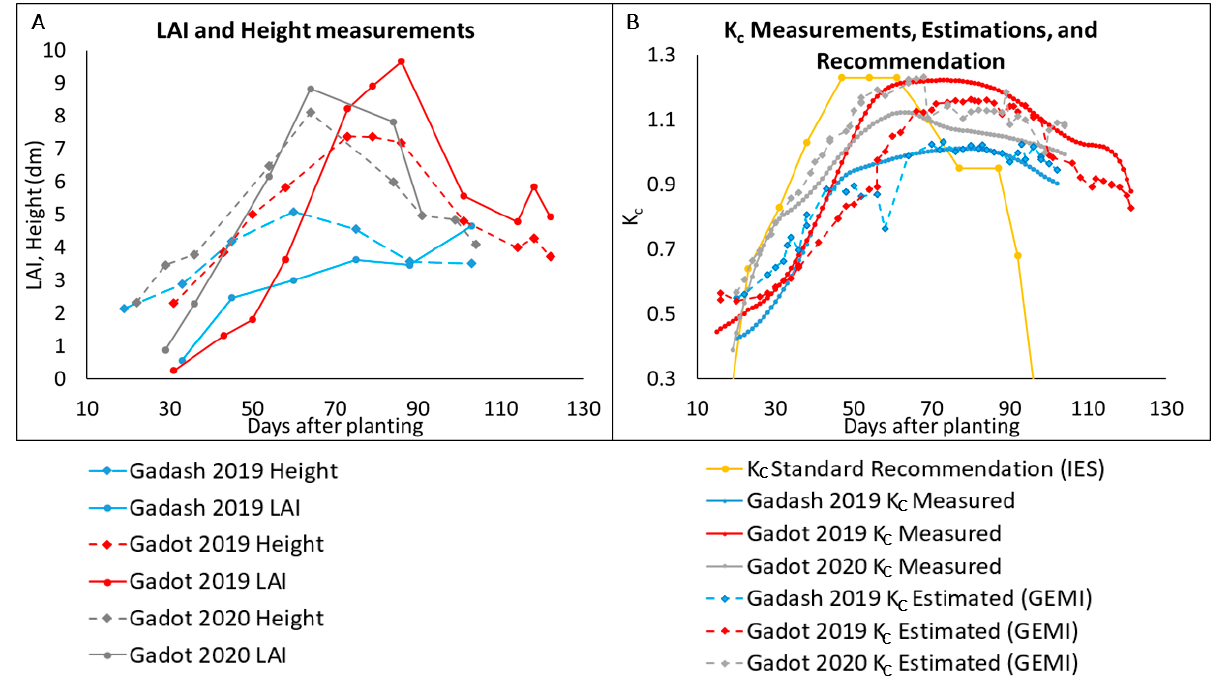
Figure 4. Data associated with three field experiments: Gadash 2019, Gadot 2019, Gadot 2020. ( A ) LAI and height measurements; ( B ) Measured, Recommended (IES), and an estimated K c (S2/V NT GEMI model).